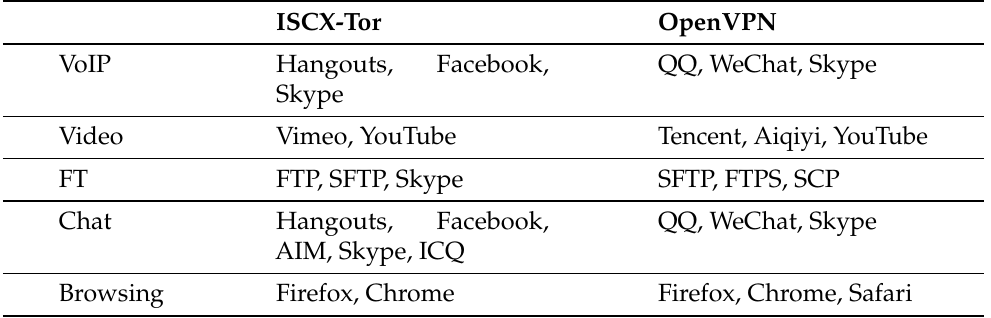
Table 1. Protocols and applications for each traffic